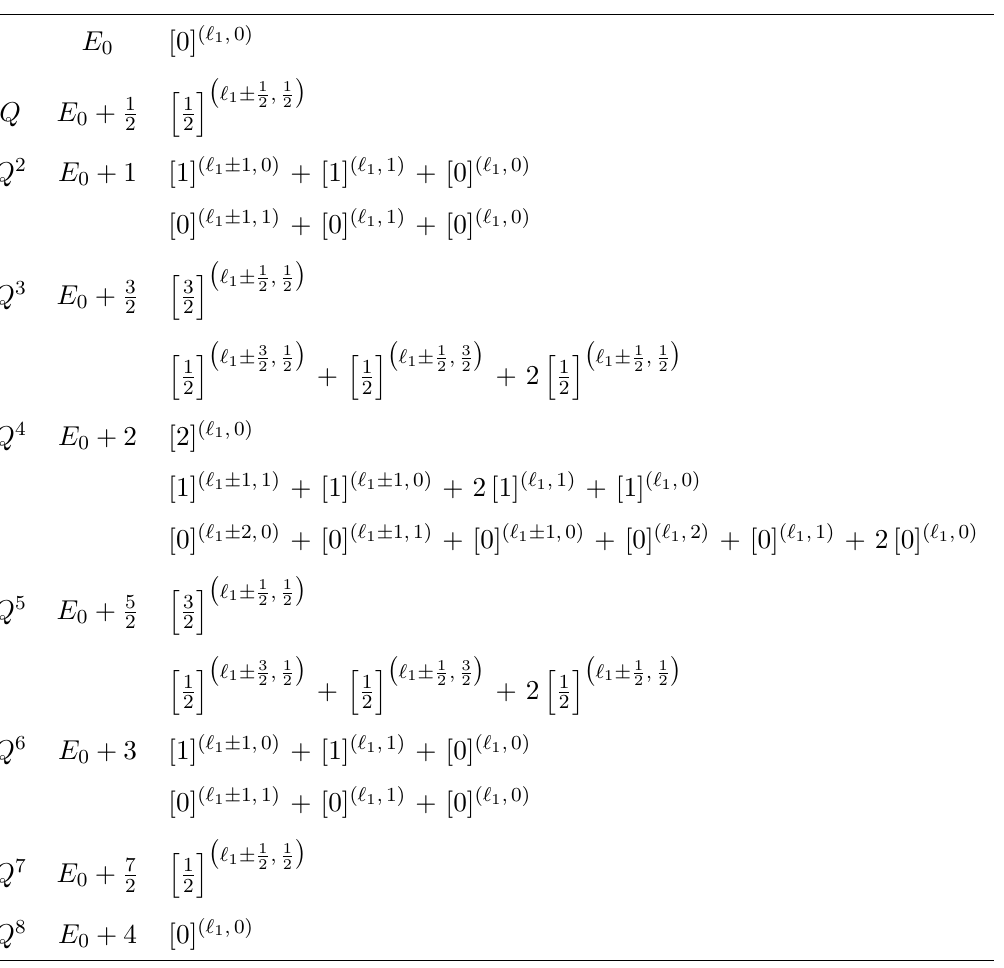
Table 9 . States in the long graviton supermultiplet LGRAV 4 [ E 0 , ‘ 1 , 0] , with ‘ 1 ≥ 3 the negative Dynkin label at the Q 4 level is